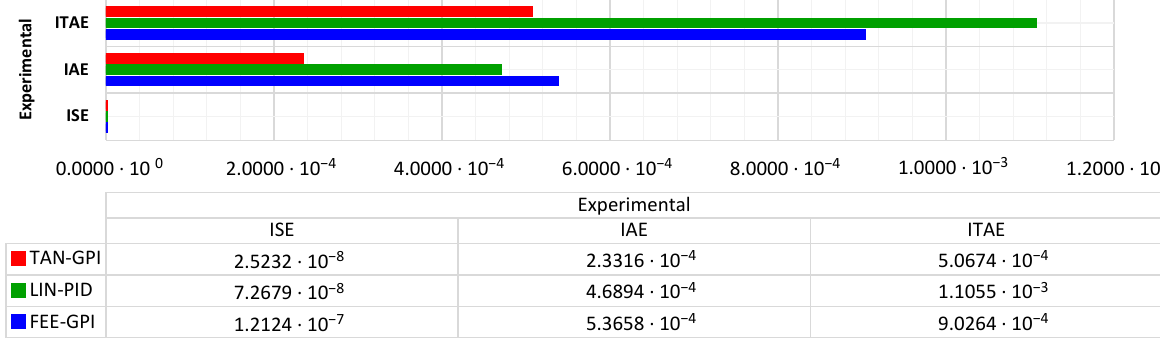
Figure 18. Performance of the control methods in experimental